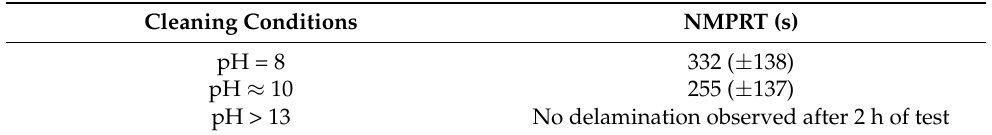
Table 4. Time to delamination in the NMP solution for the painted HDG steel as a function of the conditions of the alkaline